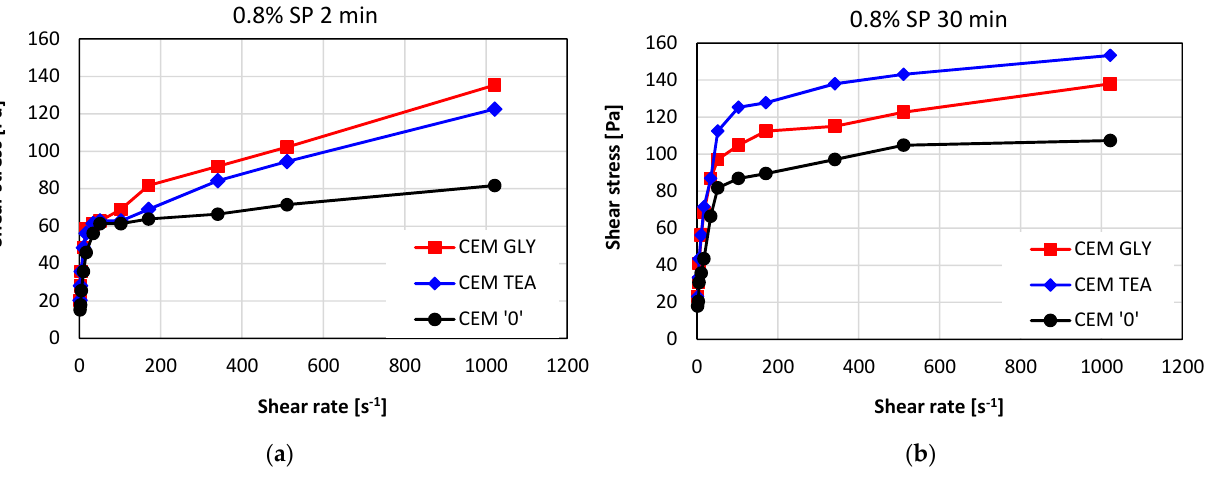
Figure 11. Flow curves of cement pastes containing an acrylic-based superplasticizer after ( a ) 2 minutes and after ( b ) 30 minutes of hydration; w/c = 0.4.